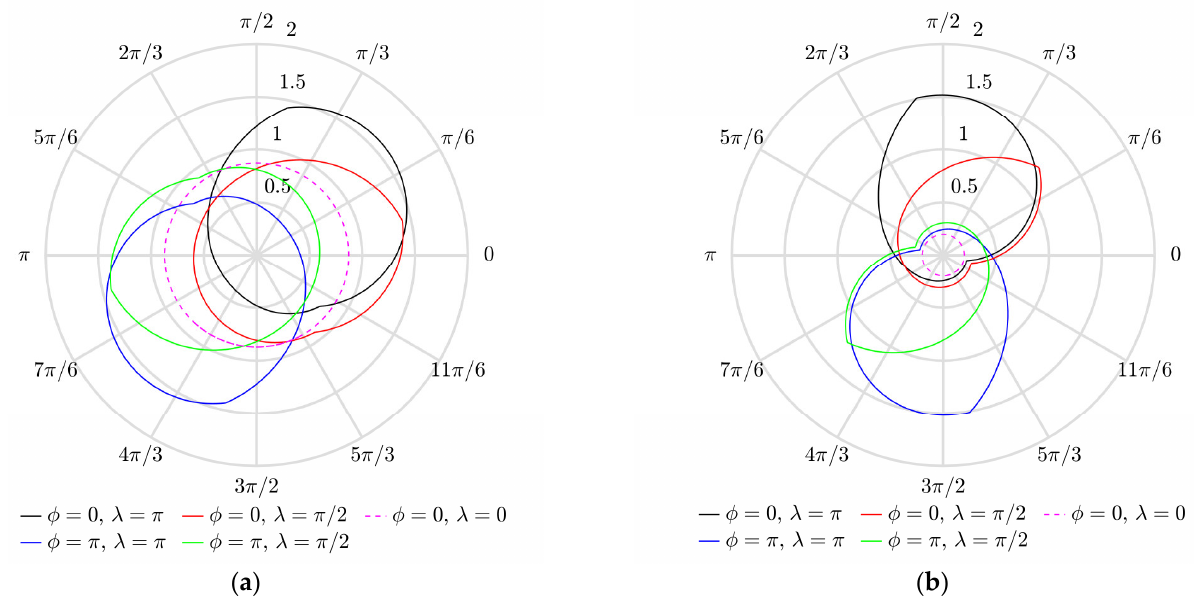
Figure 6. Variation of the angular velocity vector during the period of the eighth cycle of circular motion in polar coordinates when 〈 µ m 〉 / µ 0 = 0.25, γ = 4.9: ( a ) µ 0 = 0.1; ( b ) µ 0 = 0.2.